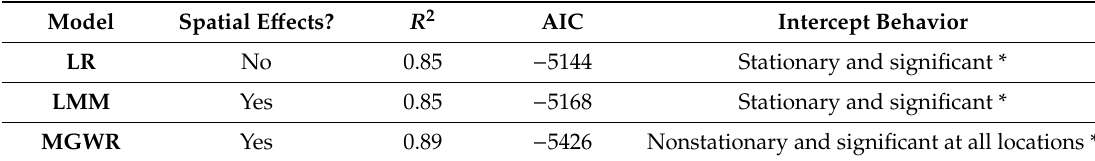
Table 3. Summary of study